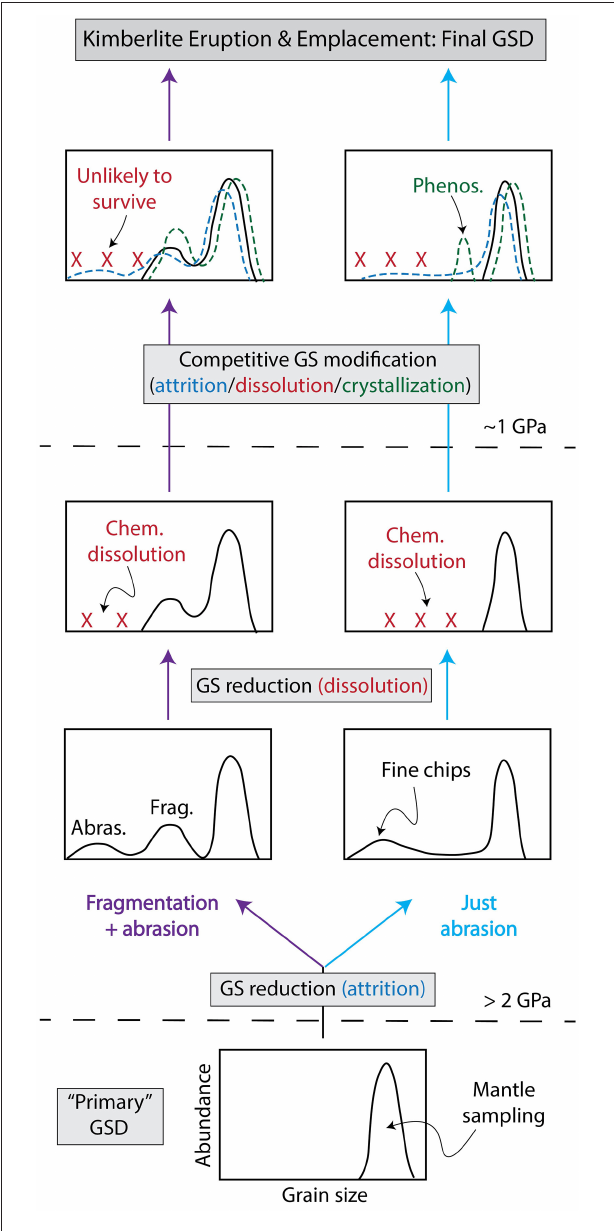
FIGURE 9 | Conceptual model for the mechanical and chemical modification of mantle-derived minerals during magma transport. Xenocrysts of minerals (i.e., olivine) are liberated from mantle xenoliths by decompression, thereby, creating a primary grain size distribution (GSD). During ascent from the deep mantle (lower portion of diagram) to the surface (upper part of diagram) the xenocrysts are modified by mechanical (fragmentation and abrasion) and chemical (dissolution and crystallization) processes. The relative importance of each process varies during ascent. Olivine grain size distributions recovered from surface kimberlite deposits inform on subsurface ascent